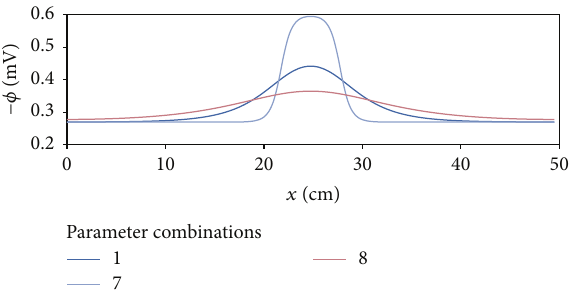
Figure 6: Electrical potential profile on concrete surface for differ- ent concrete cover depths.